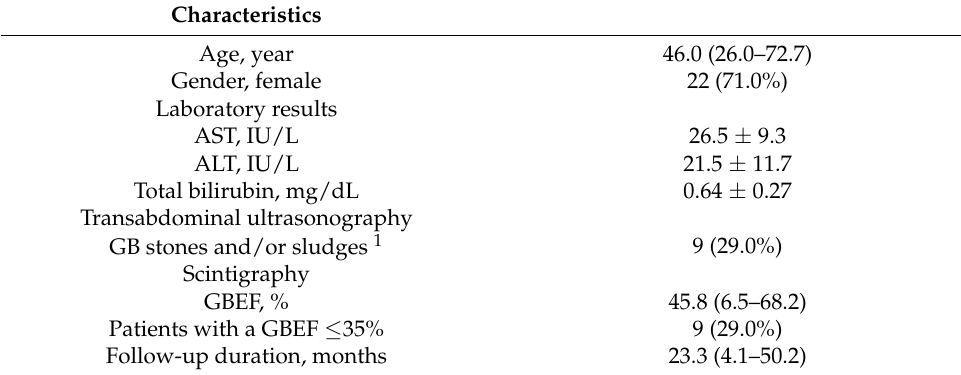
Table 1. Baseline characteristics ( n =